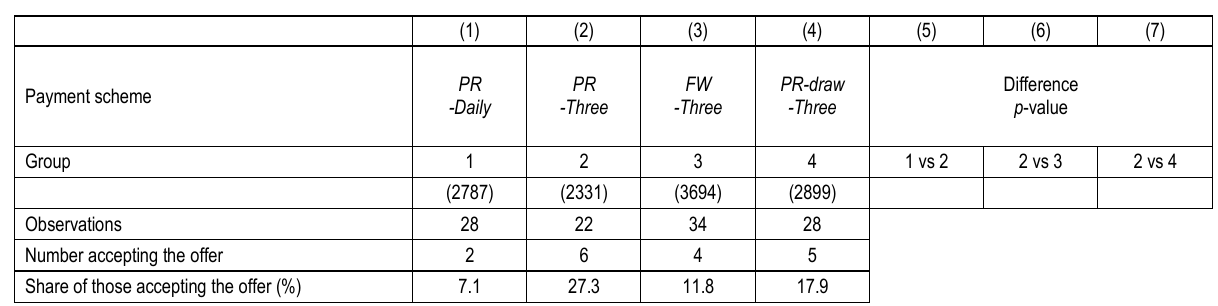
Table 2. (cont.) Summary statistics by group